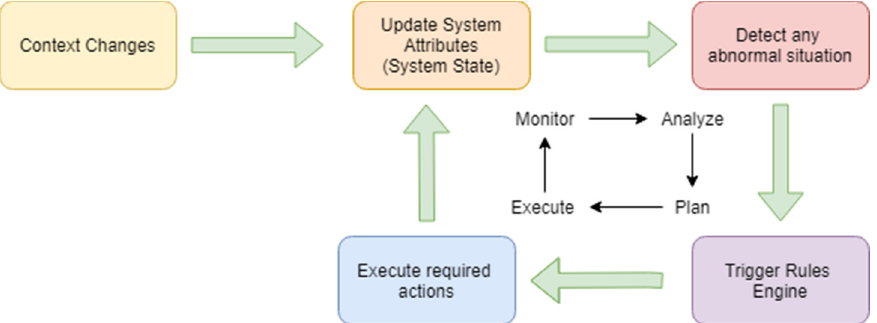
Figure 3. Adaptation lifecycle.